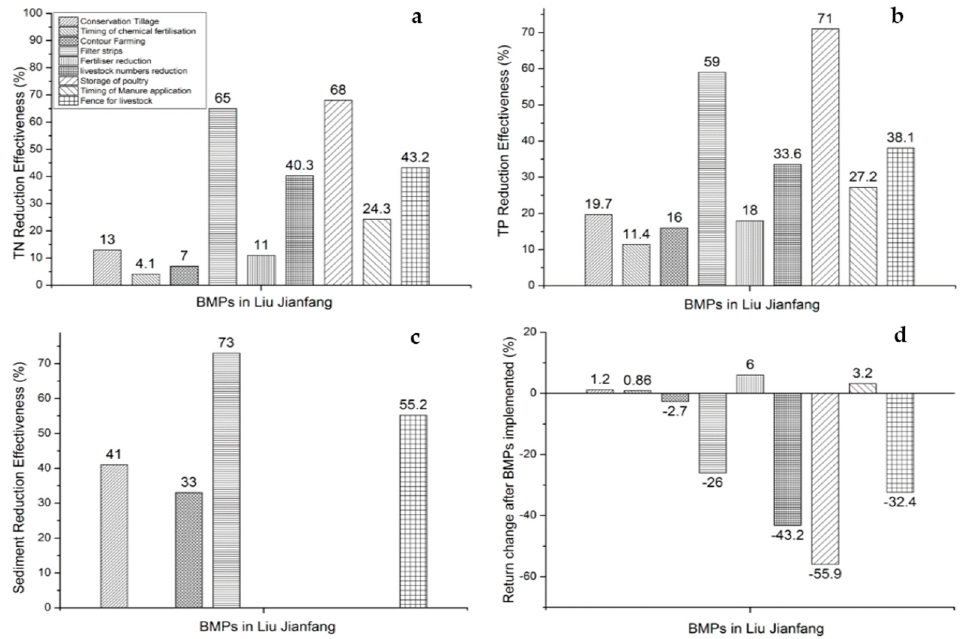
Figure 7. BMP assessment at VLJF, ( a ) the TN reduction effectiveness; ( b ) TP reduction effectiveness;